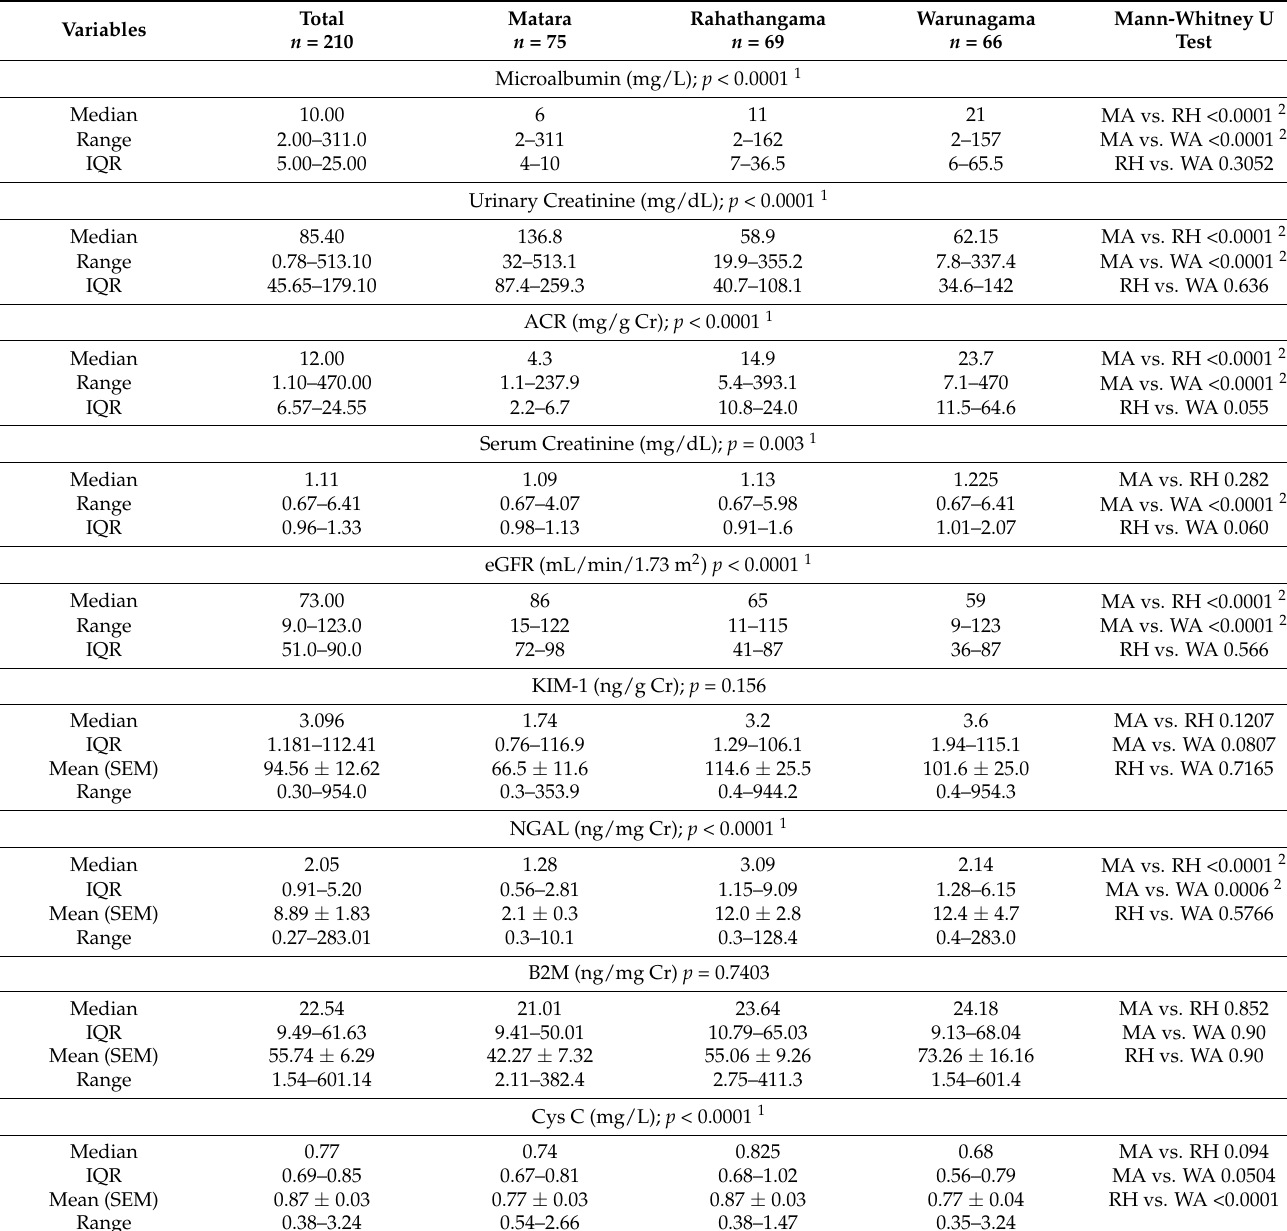
Table 3. Creatinine-adjusted biomarkers of kidney injury KIM-1, NGAL, B2M, Cys C and kidney functions among MA, RH and WA farming communities.